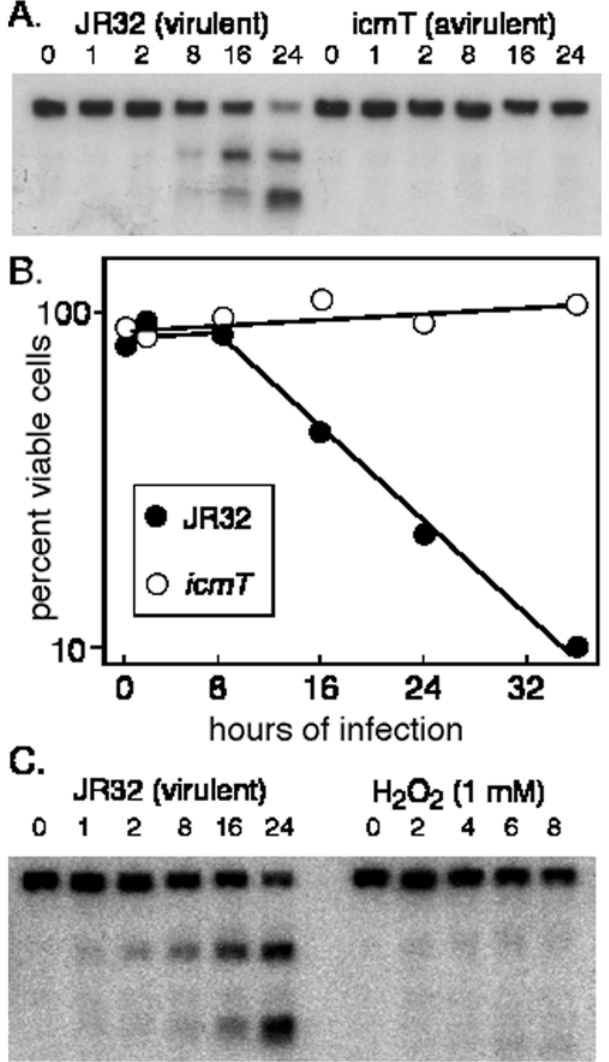
Figure 2. Cleavage of mitochondrial LSU rRNA during infec- tion. (A) D. discoideum cells were infected with L. pneumophila at an MOI of 10. Total RNA was extracted after 1, 2, 8, 16 and 24 hours of infection and probed on a northern blot with a DNA fragment corresponding to the 5 9 end (basepairs 144 to 377) of D. discoideum mitochondrial LSU rRNA. (B) The same infection was used to determine D. discoideum cell viability by scoring the number of viable cells by determining the number of colonies produced after recovery of the infected cells on bacterial lawns. Infection with the virulent strain JR32 (closed circles); infection with the avirulent strain icmT (open circles). (C.) D. discoideum cells were infected either infected with L. pneumophila , or treated with 1 mM hydrogen peroxide, as described above and mitochondrial LSU rRNA was visualized by northern blots.